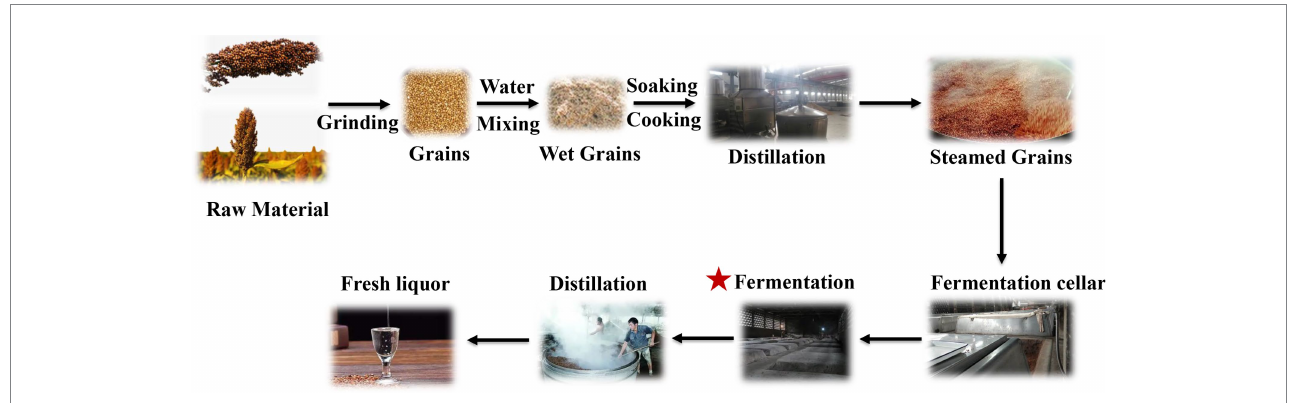
FIGURE 1 Jiupei production process